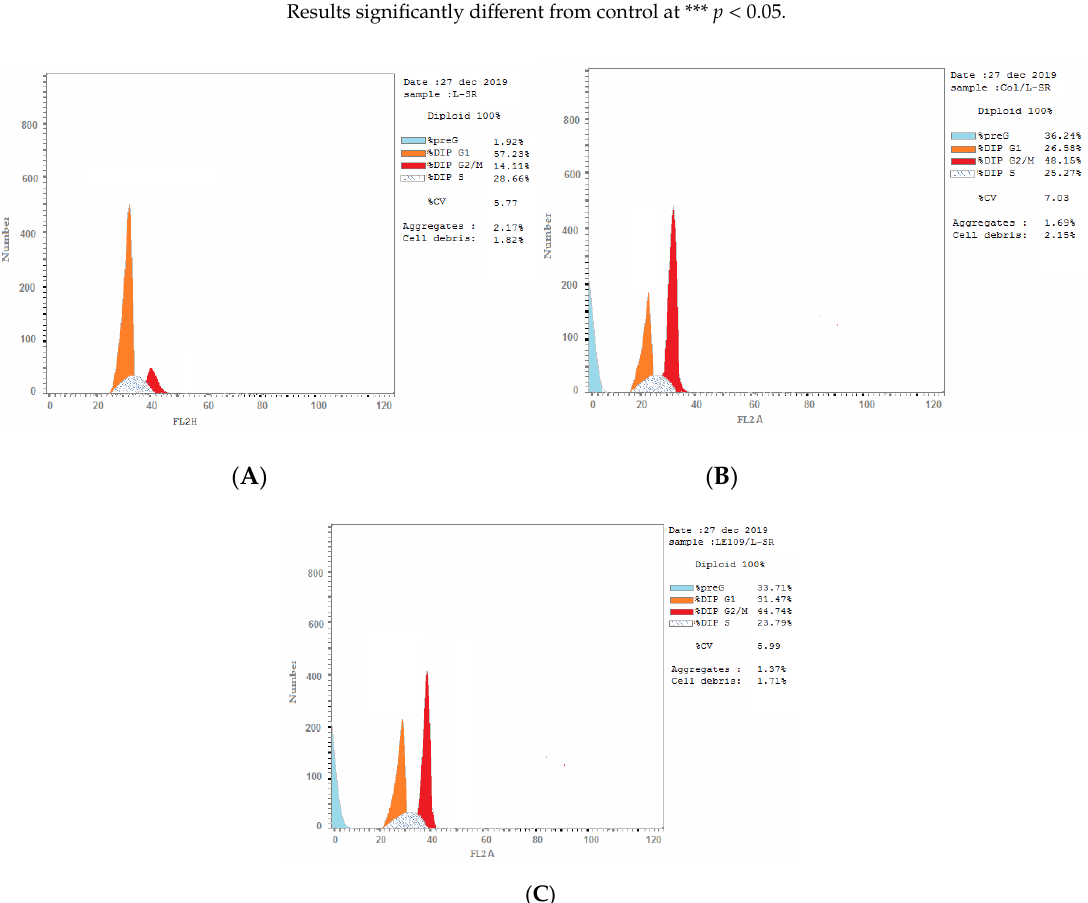
Figure 10. Cell-cycle analysis of SR cells treated with annexin PI at IC 50 . Concentration representing growth arrest at the pre-G1 (G0) and G2 / M phases. ( A ) Untreated cells; ( B ) treated cells with colchicine; ( C ) treated cells with 3a. The test was repeated three times, while 3a and the reference were incubated for 24 h (2 × 10 5 cells / well) at 37 °C.